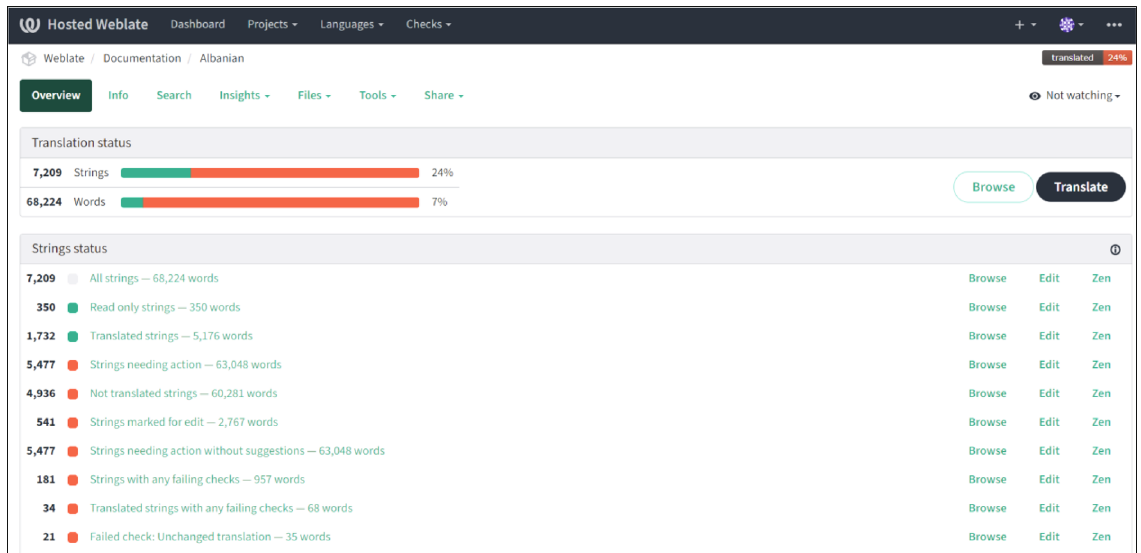
Figure 4: Screenshot of a TMS: Weblate [34], an open source web-based system for